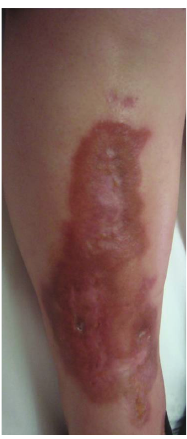
Figure 2: Healed lesion after 12 weeks of